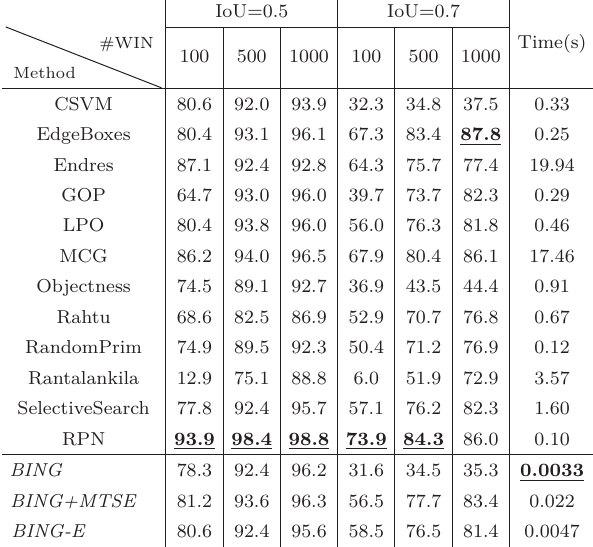
Table 3 Detection recall (%) using different IoU thresholds and #WIN on the VOC2007 test set IoU=0.5